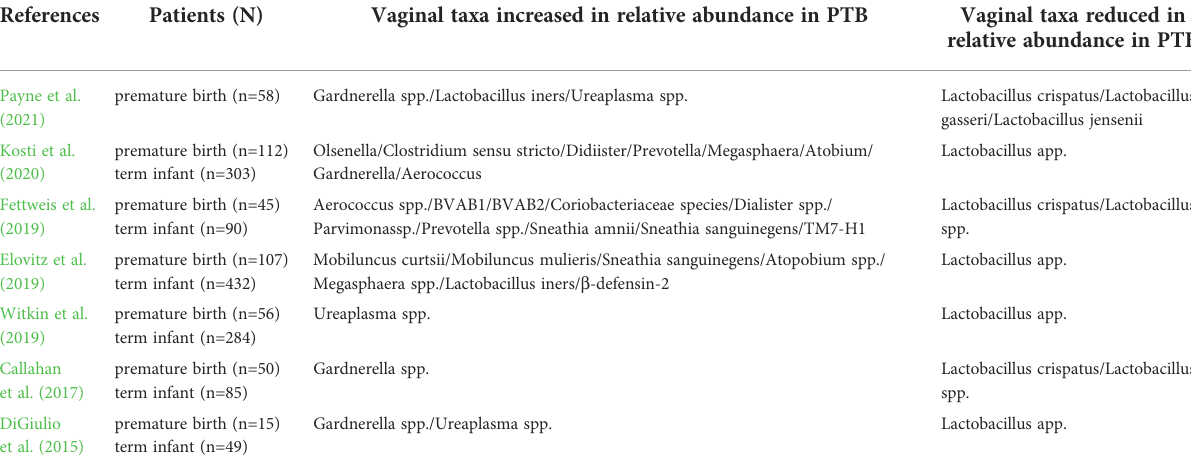
TABLE 1 Latest Research on Female Reproductive Tract Microbes and Preterm